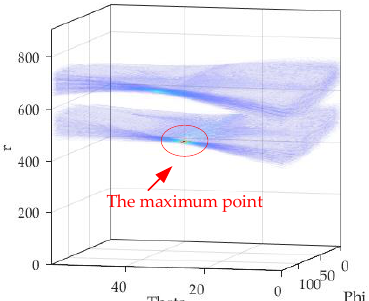
Figure 4. The 3D Hough transform result in parameter space. Figure 11. The 3D Hough transform result in parameter space.